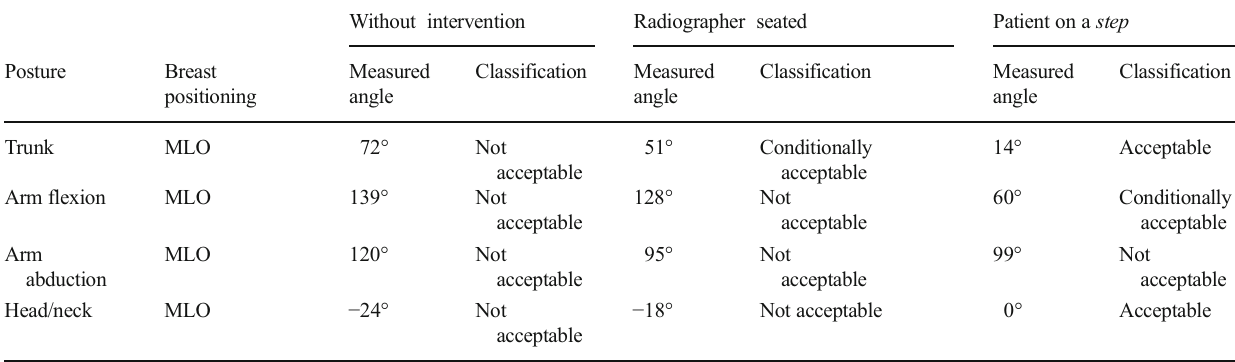
Angles measured on radiographer performing MLO breast positioning (radiographer taller than the patient) Without intervention Radiographer seated